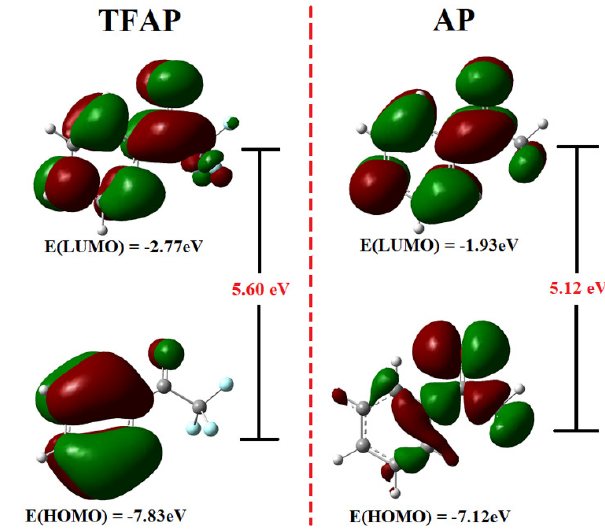
Figure 2. Optimized structure and atom numbering of TFAP